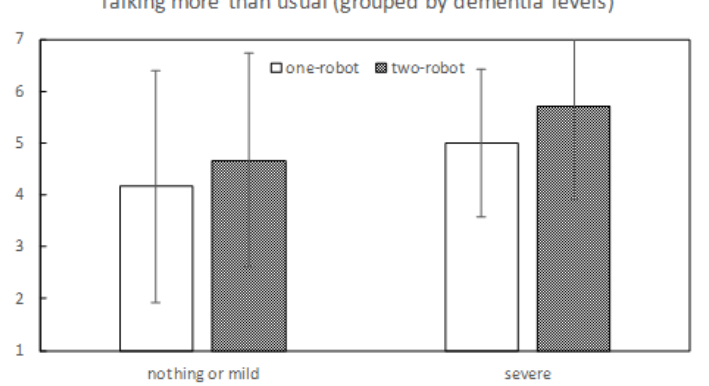
Figure 12. Averages of the scores of the question to the caregivers, grouped by dementia levels of the participants.